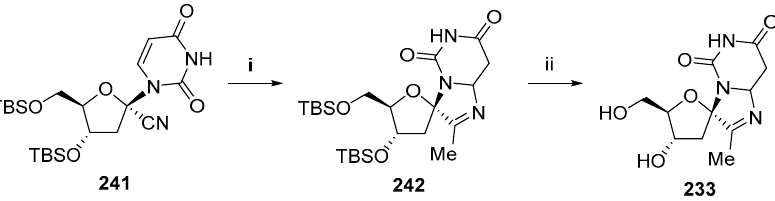
Scheme 46. Reagents and conditions: (i) Ac 2 O, Py, 93%; (ii) Br 2 , EtOH, 63%; (iii) NH 3 , MeOH,